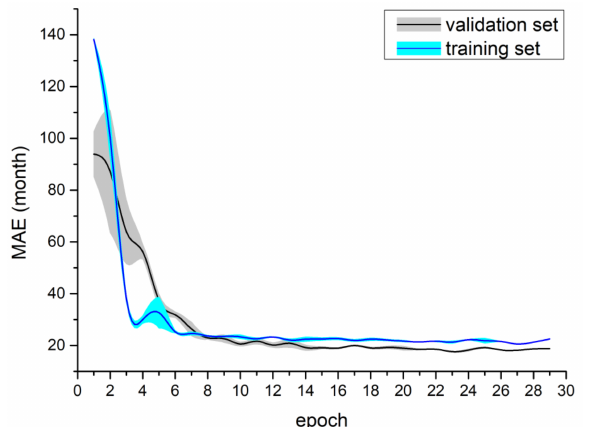
Figure 7. Training process for the attention model using the DXA dataset—mean and standard deviation calculated from five